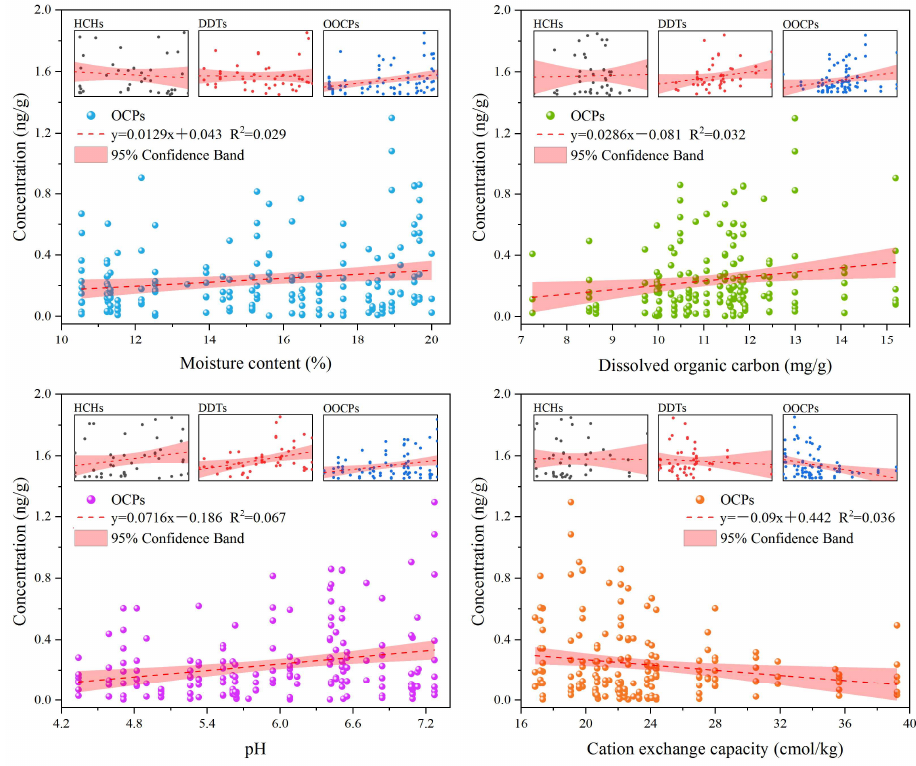
Figure 4. Linear regression analysis between soil properties and